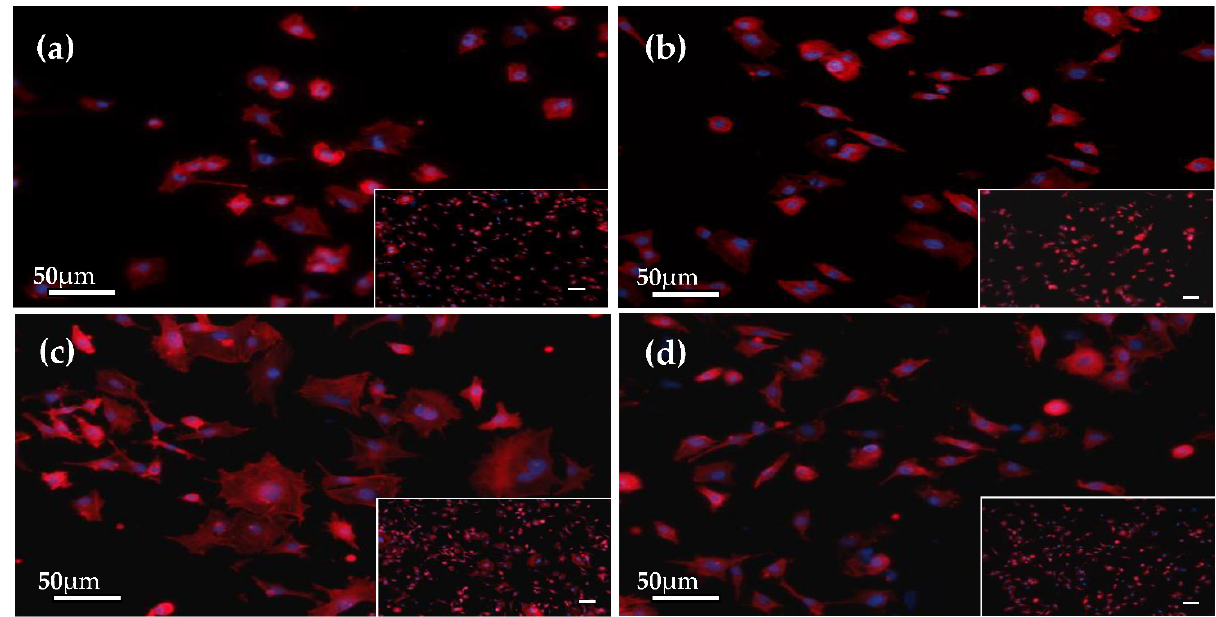
Figure 7. Fluorescent images of the MC3T3-E1 pre-osteoblasts after culturing for 4 h: ( a ) untreated control, ( b ) the Mg-10 system, ( c ) the Mg-10-KOH-5 system and ( d ) the Mg-10-KOH-8 system. The scale bar in the low-magnification insets is 100 μ m.